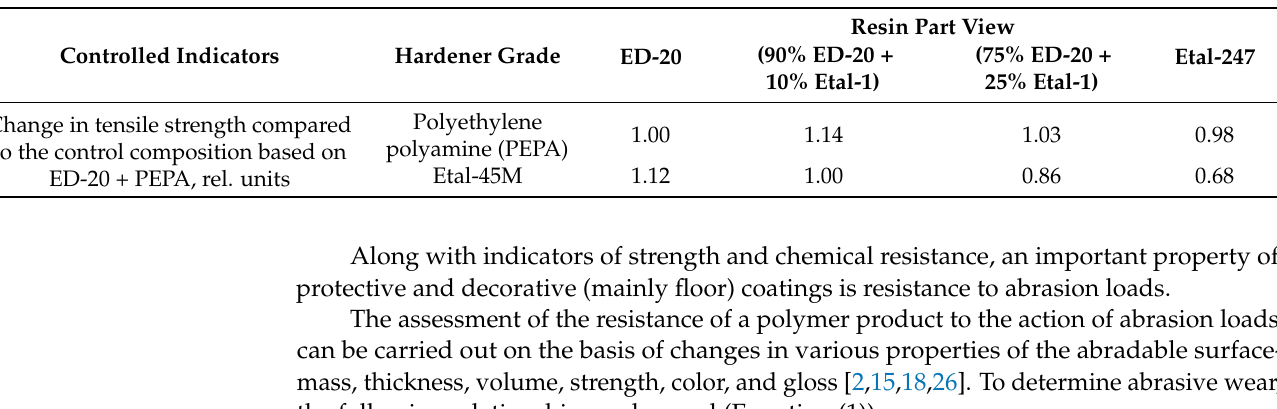
Figure 4. EP tensile strength depending on the brand of hardener used. Table 5. EP strength indicators depending on the type of resin part and hardener.